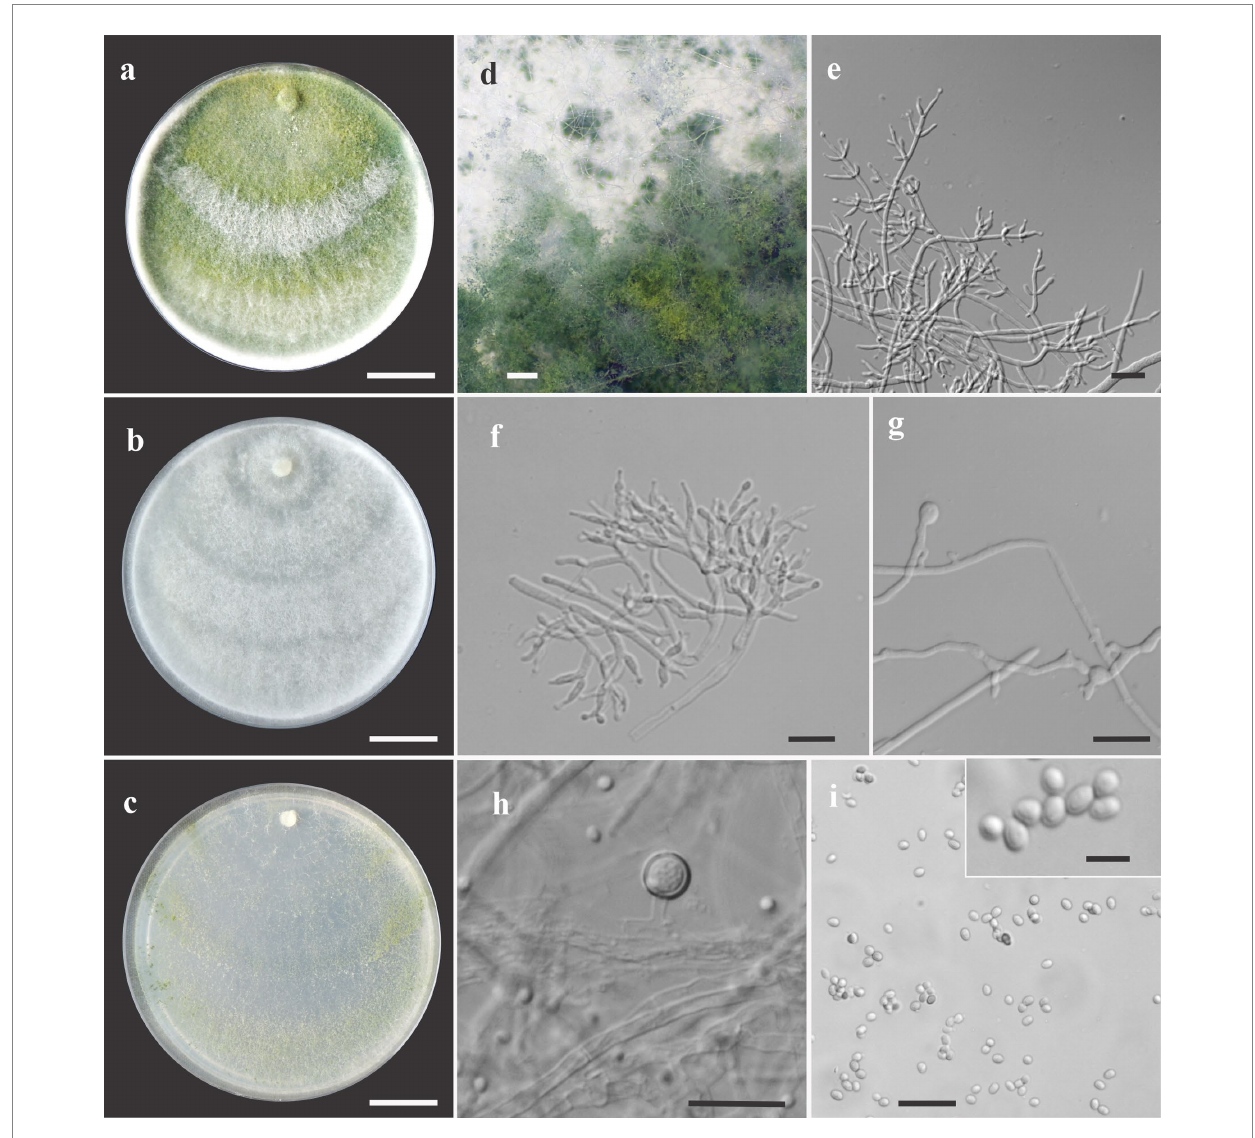
FIGURE 3 Asexual morph of Trichoderma acreanum sp. nov. from Hevea brasiliensis (VIC47506, holotype). ( A–C ) Colony appearances (PDA, CMD, and SNA; 7 days, 25 ° C). ( D ) Sporulating pustules (SNA). ( E , F ) Conidiophores and phialides (SNA). ( G ) Chlamydospore (after 48 h). ( H ) Chlamydospore (after 7 days). ( I ) Conidia. Scale bars: ( A–C ) 20 mm, ( D ) 0.2 mm, ( E , F ) 15 μ m, ( G ) 10 μ m, ( H ) 25 μ m, ( I ) 20 μ m (inside = 5 μ